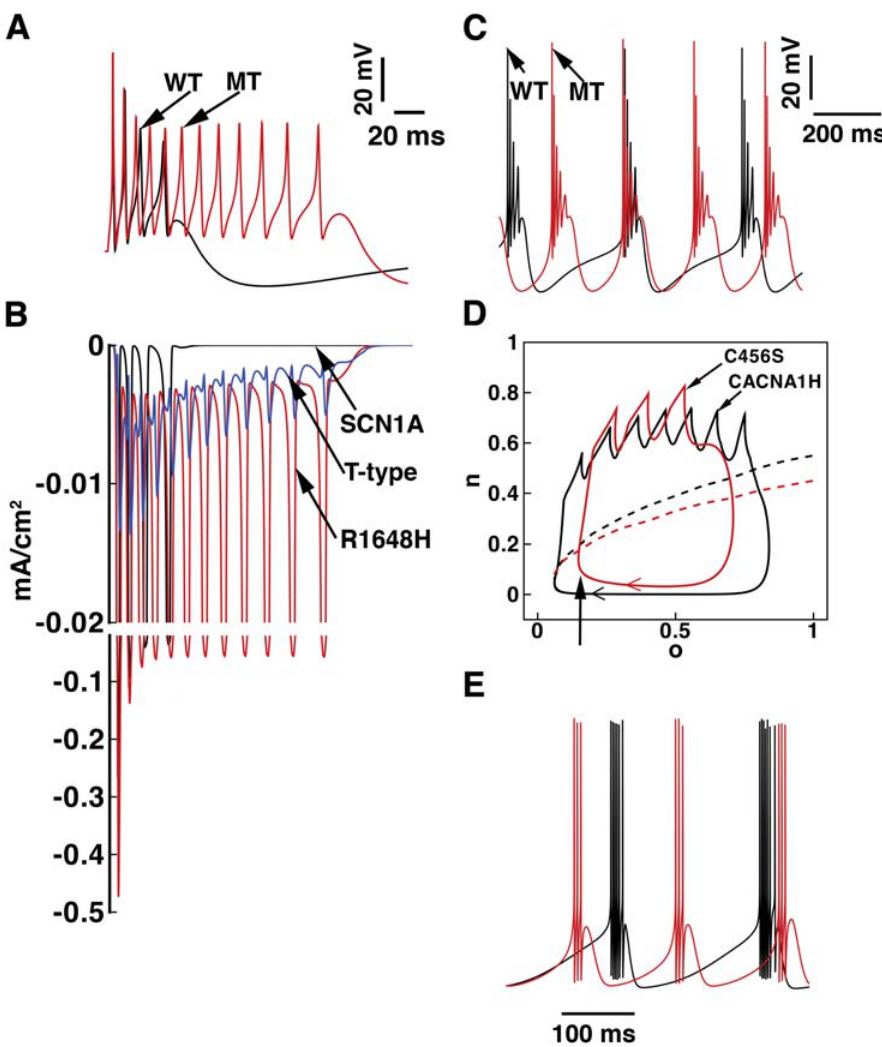
Figure 8. The effects of Na + and T-type Ca 2 + channel mutations on neuronal excitability . Panels A and B show the bursting behavior of the wild-type Na V 1.1 and mutant R1648H model neurons. (A) Action potentials were generated in response to a brief (5 ms) 0.2 nA current injection for R1648H (red line) and wild-type Na V 1.1 (black line). (B) The corresponding wild-type Na V 1.1 and mutant R1648H Na + current (on split scale). T-type Ca 2 + current is also plotted for comparison. Note that the persistent Na + current between spikes is much more prominent for R1648H compared with the wild-type. Panels C, D, and E show the bursting behavior of the wild-type Ca V 3.2 and C456S single nucleotide polymorphism (SNP) model neurons. (C) Action potentials were generated in response to a steady 0.001 nA current injection for single nucleotide polymorphism (SNP) C456S (red line) and wild-type Ca V 3.2 (black line) model neurons. The single nucleotide polymorphism (SNP) C456S increases the frequency of firing (e.g., reduces the intervals between bursts) (red line), compared to the wild type (black line). (D) Fast-slow analysis with wild-type Ca V 3.2 (black) or single nucleotide polymorphism (SNP) C456S (red) channels in a reduced model. The phase plot shows the projection of the burst trajectory onto the slow variable n – o plane ( n : the activation gate of Ca V 3.2; o : the activation gate of Ca 2 + -dependent K + channel). The dashed lines denote the stability line that separates resting states (below the line) from firing states (above the line). The arrows indicate the direction of the trajectory. (E) The action potentials corresponding to the parabolic burst firings as shown in B in the reduced model.